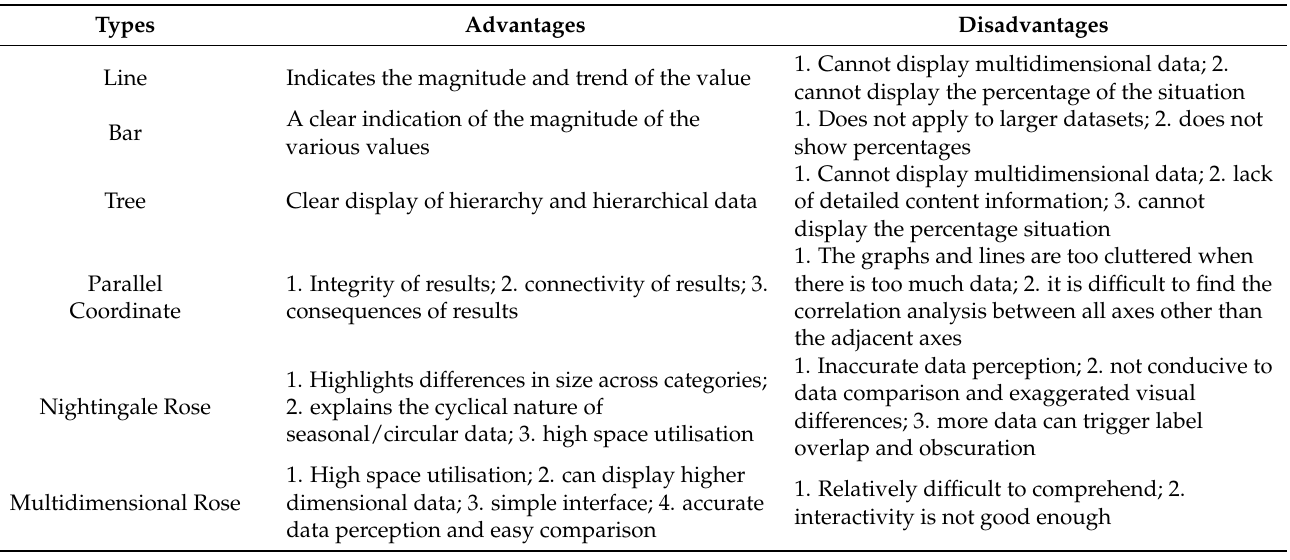
Table 2. Advantages and disadvantages of the six